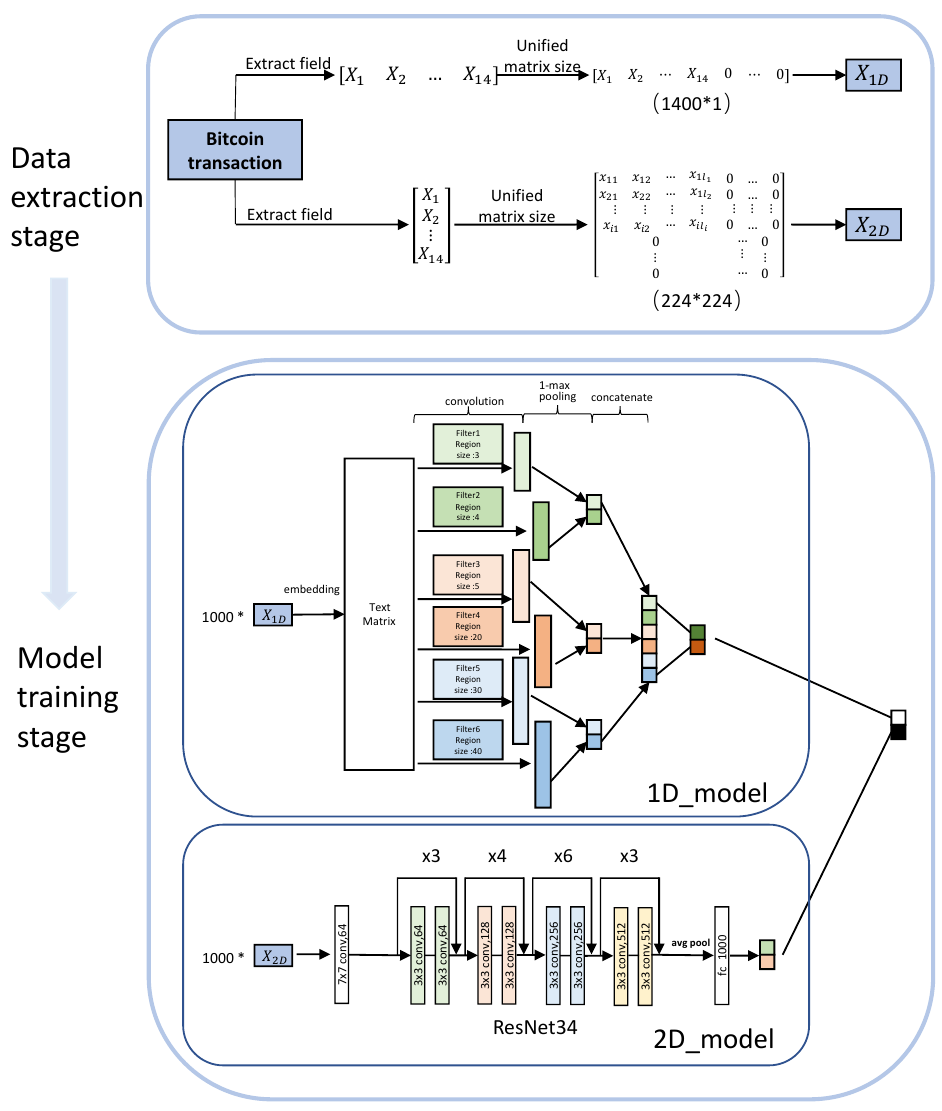
Figure 5. Architecture of the M-CTR